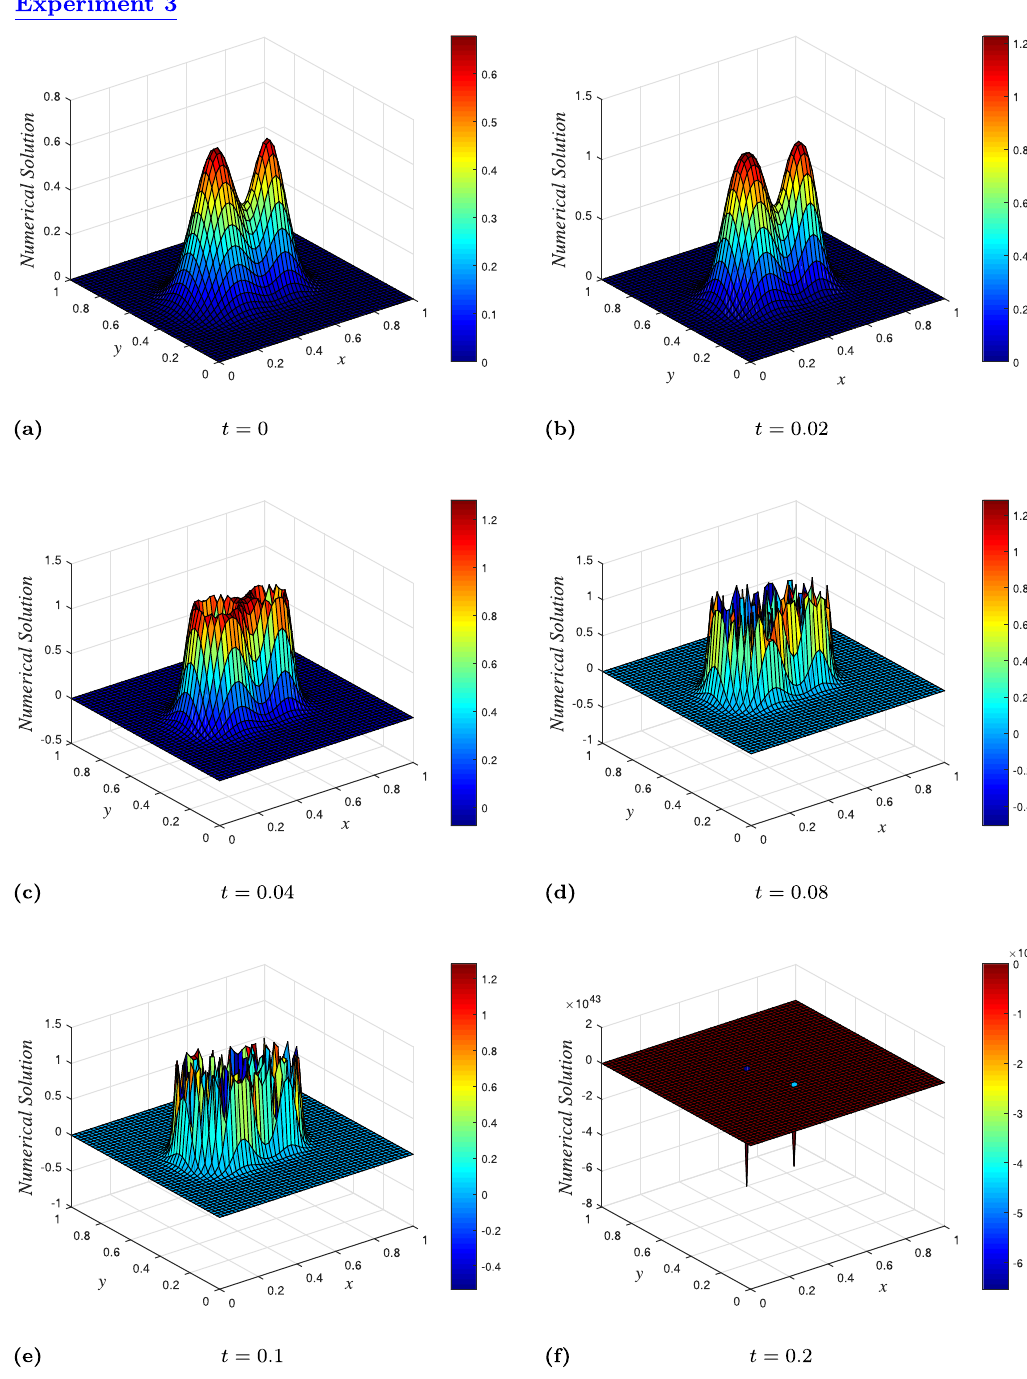
Figure 5: Plot of numerical solution vs x vs y using Classical scheme at times = t 0, 0.02, 0.04, 0.08, 0.1 , and 0.2 with spatial step sizes = = h h 0.02 x y and time - step = k 0.02 . ( a ) = t 0 . ( b ) = t 0.02 . ( c ) = t 0.04 . ( d ) = t 0.08 . ( e ) = t 0.1 . ( f ) = t 0.02